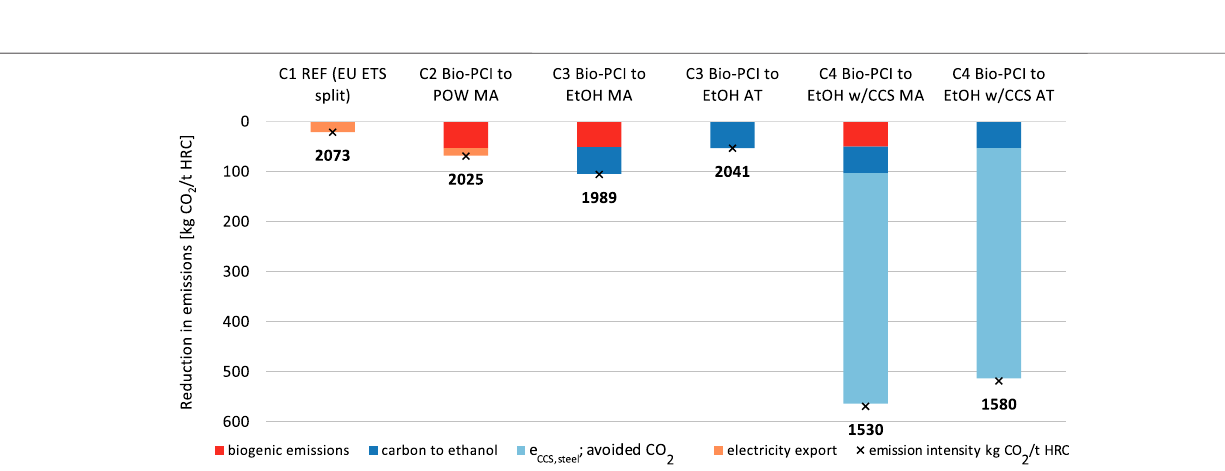
(cid:129) For the C4 con fi guration, the extra fossil-related emissions at low levels of integration are allocated to both the syngas